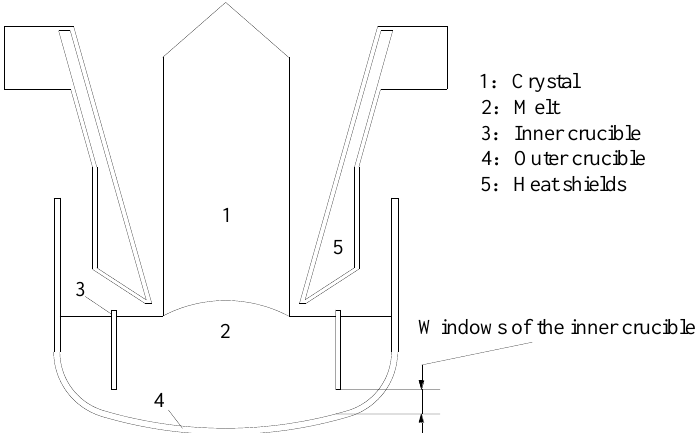
Figure 1. Schematic diagram of the continuous-feeding Czochralski method (CCZ) furnace with double crucibles. Table 1. The dimensions of the continuous-feeding Czochralski method (CCZ) furnace. Crystal Diameter